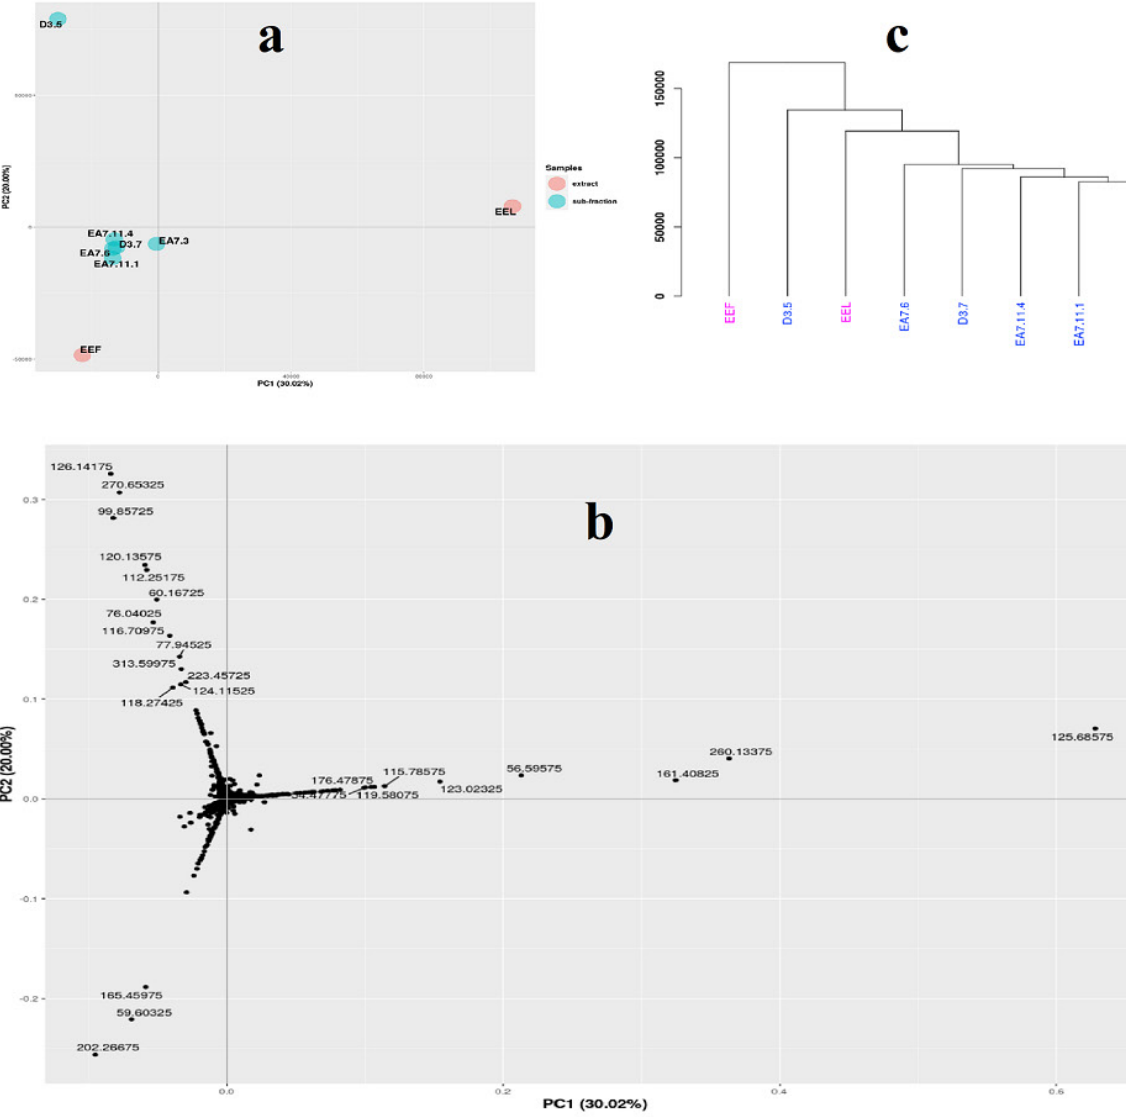
Figure 3. Principal component plots and a dendrogram of MS data: a) score plot for PC1 x PC2; b) loadings for PC1 x PC2; c) HCA dendrogram. Ethanolic extracts: EEL (leaves), EEF (flowers); Sub-fractions: D3.5, D3.7, EA7.6, EA7.11.1, EA7.11.4, and